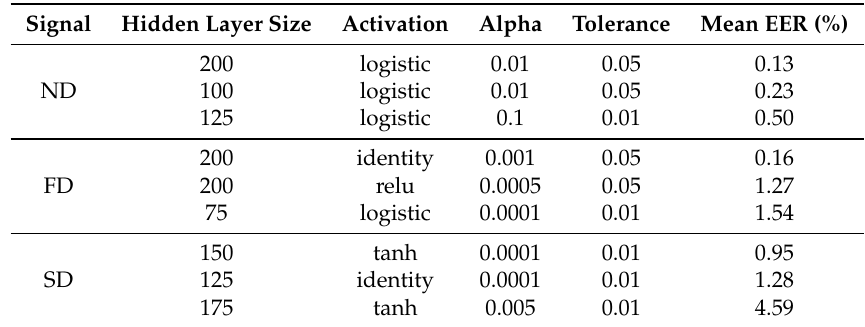
Table 5. Best hyperparameter values in Random Search and their Equal Error Rates (EERs) for Non-Differentiation (ND), First Differentiation (FD), and Second Differentiation (SD).